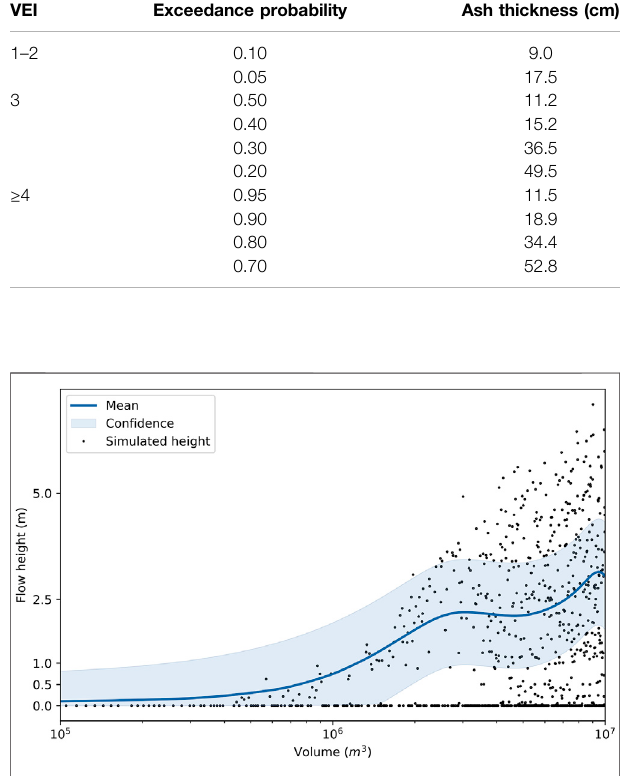
FIGURE 5 | Simulated maximum fl ow heights near North Egmont Visitors Centre for all simulations of Mead et al. (2022) (black dots), emulated mean height and 95% con fi dence interval (blue line and shading) for dome collapses located and oriented similar to the current remnant dome of Taranaki.